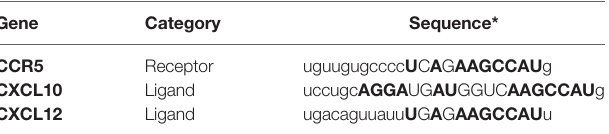
*Bold capital letters represent predicted miR-135a binding